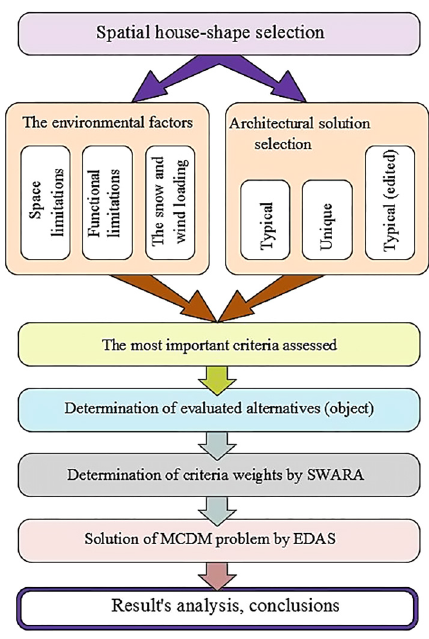
Fig. 3. Spatial house-shape selection